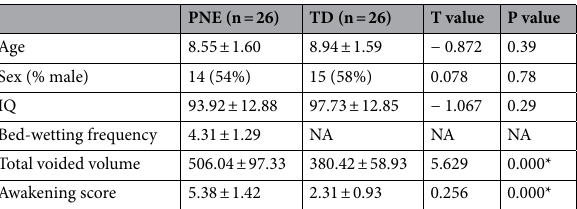
Table 1. Demographic and clinical data (x ± s). *P < 0.05. Total voided volume means the amount of urine remaining in the bladder. The chi-square test was used for P-value of